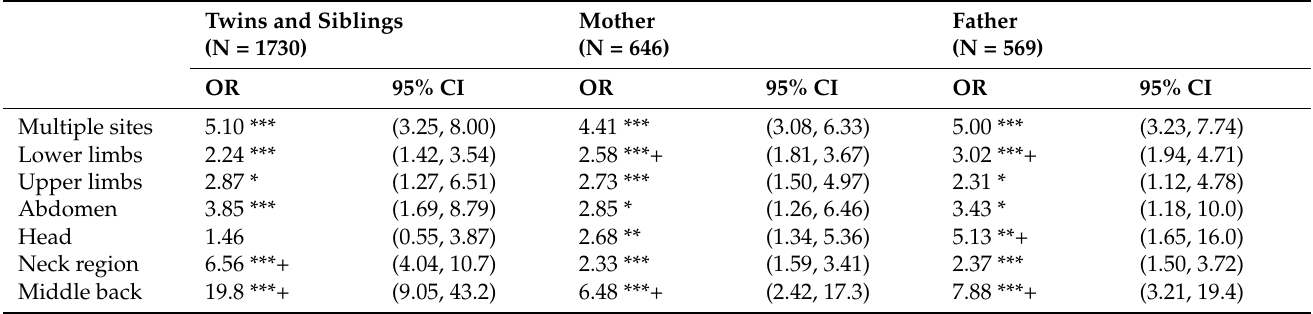
Table 6. Associations between pain in other body regions and LBP